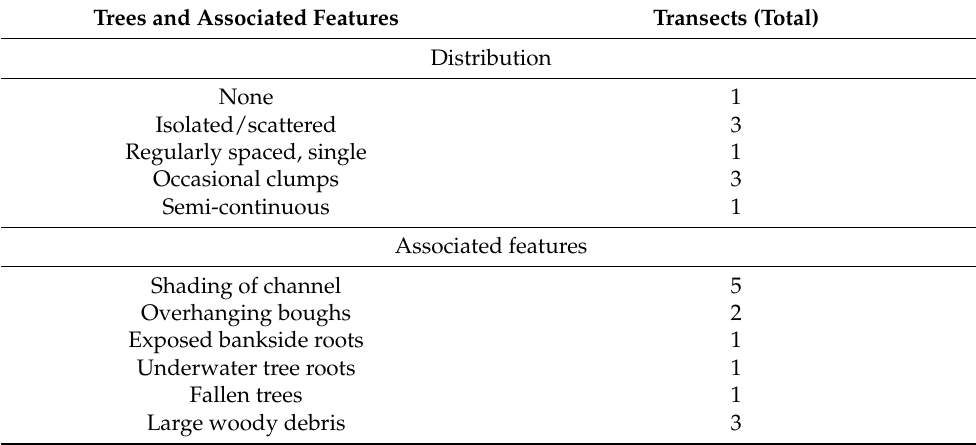
Table 7. Representativeness of observations in Section J. Trees and Associated Features Transects (Total)